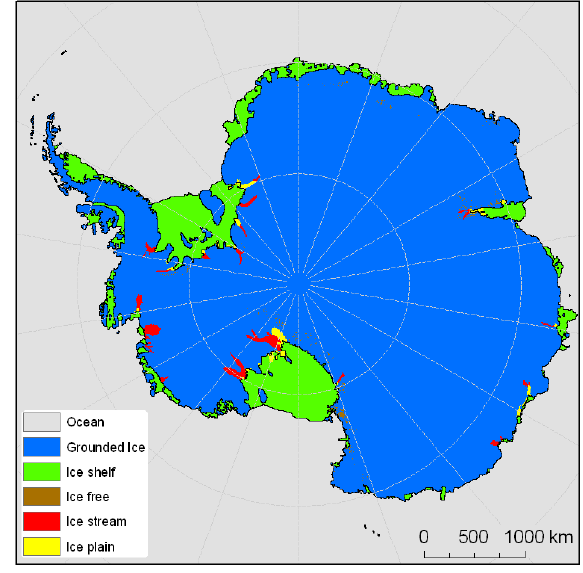
Figure 1. Combination of mask, mask + and